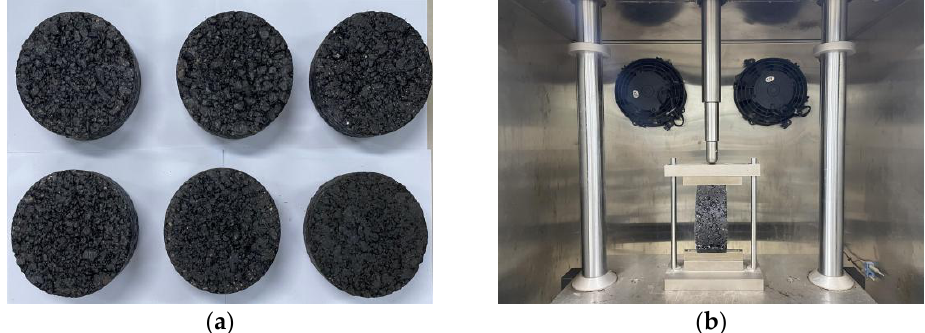
Figure 4. IDEAL cracking test load-displacement curve.